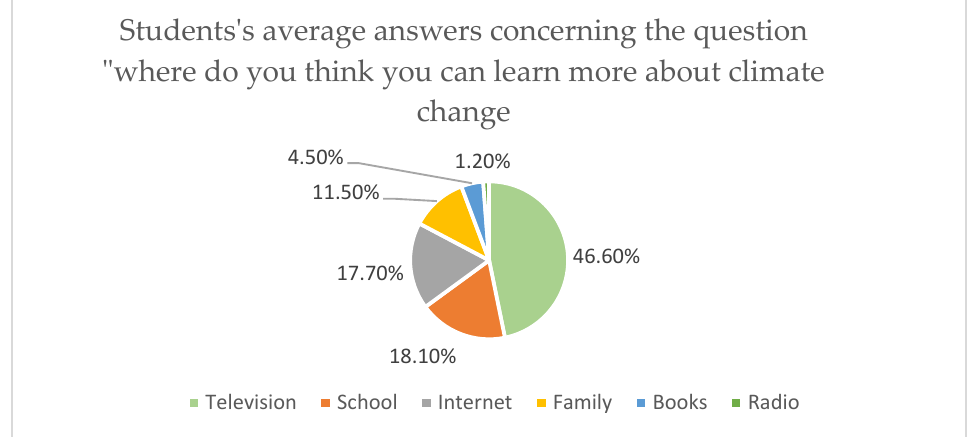
Figure 4. Distribution of average respondents’ answers to the question “Where do you think you can learn more about climate change?”.